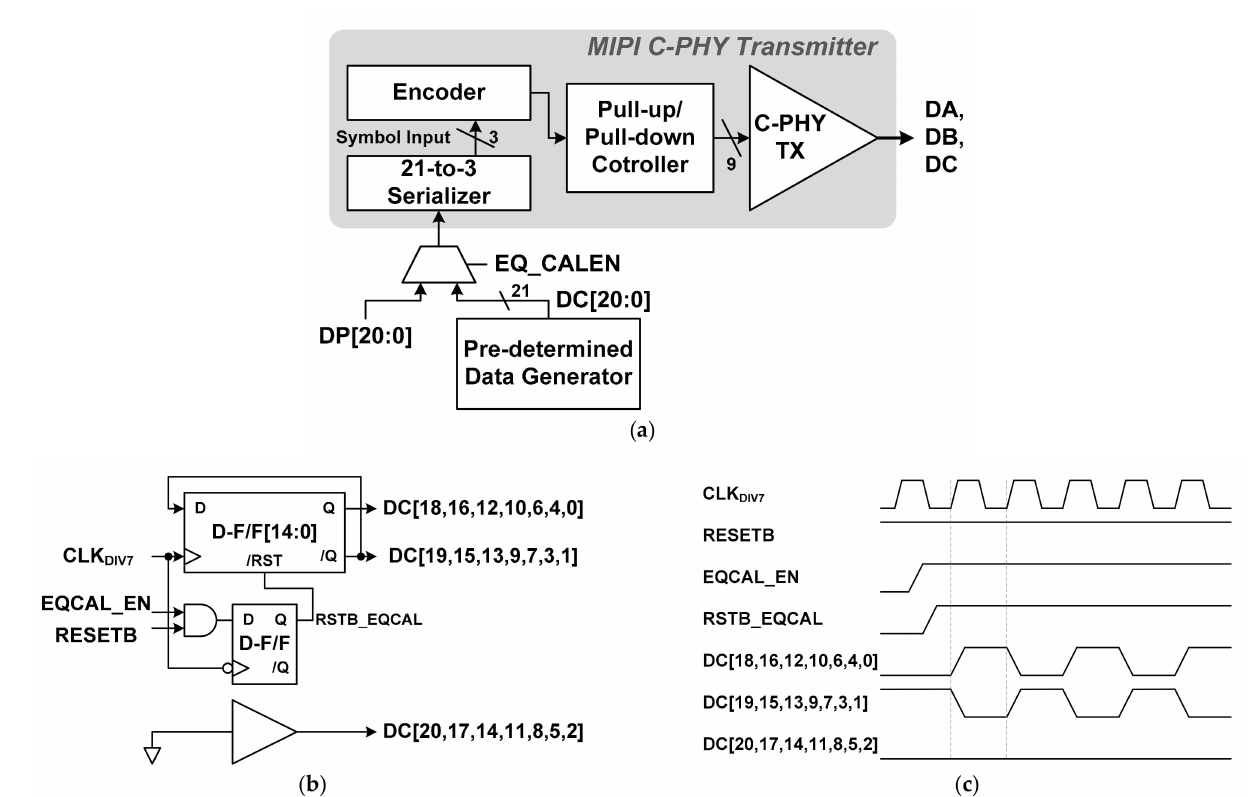
Figure 5. Pre-determined data generator: ( a ) Connection between MIPI C-PHY transmitter and pre-determined data generator; ( b ) Block diagram for pre-determined data generator; ( c ) Time diagram of pre-determined data generator.